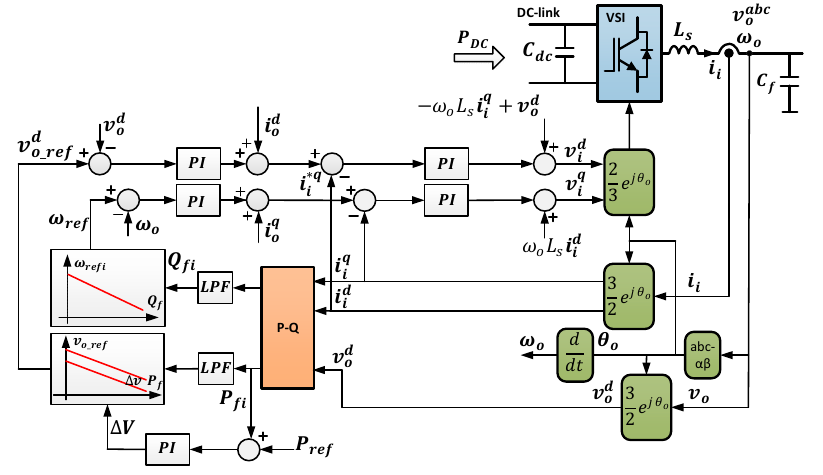
Figure 6. Control system overview.